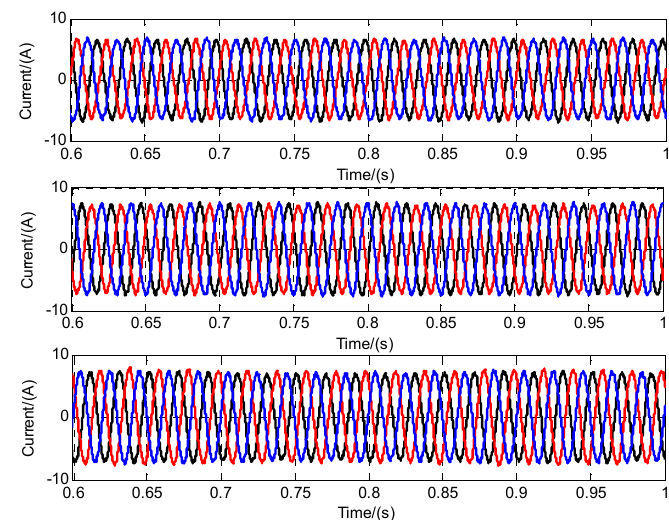
18 of 21 Figure 22. Torque spectrum under stator faults (top: health, middle: 5 turns shorted, bottom: 20 turns shorted). 5.3. Rotor Faults